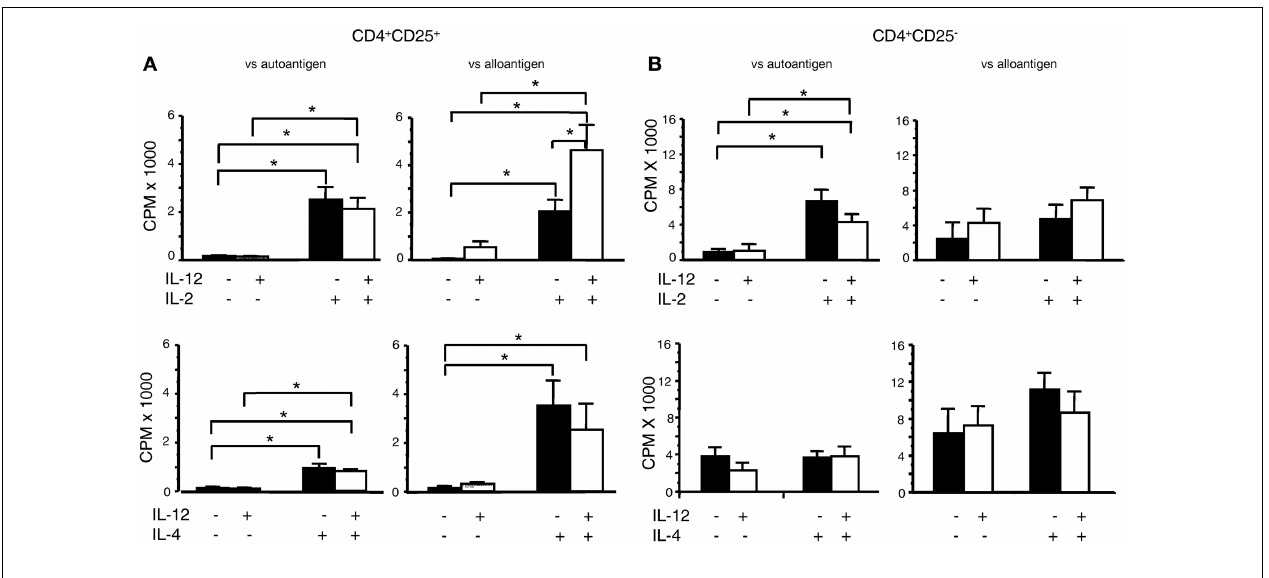
proliferation assessed at day 4.The cells were fresh and had not been cultured before. Addition of rIL-12p70 enhanced proliferation of CD4 + CD25 + T cells to alloantigen, not auto-antigen, in cultures with rIL-2 but not with rIL-4. rIL-12p70 had no significant effect on proliferation of CD4 + CD25 − T cells, even when rIL-2 was present. *Significant differences ( p < 0.05). Similar results have been obtained in other